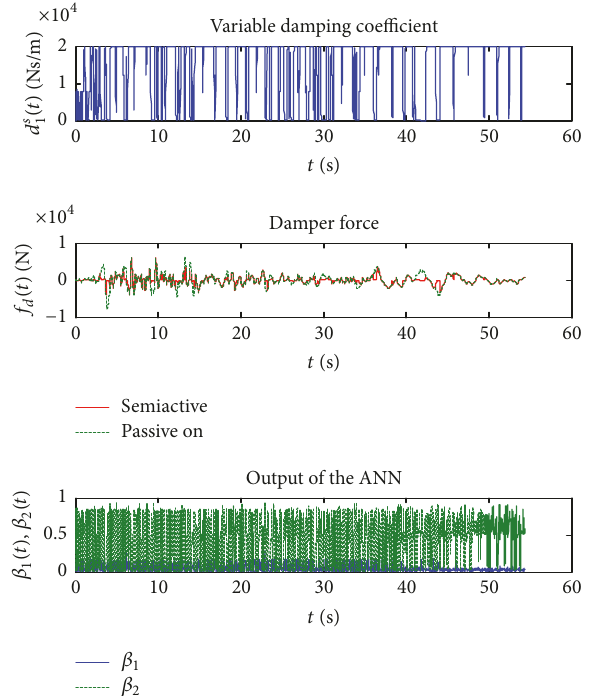
Figure 21: Simulation results for the Taft NS (1952) earthquake disturbance; variable damping coefficient 𝑑 𝑠 1 (𝑡) , force of damper 𝑓 (𝑡) , and output signals of the ANN 𝛽 𝑑